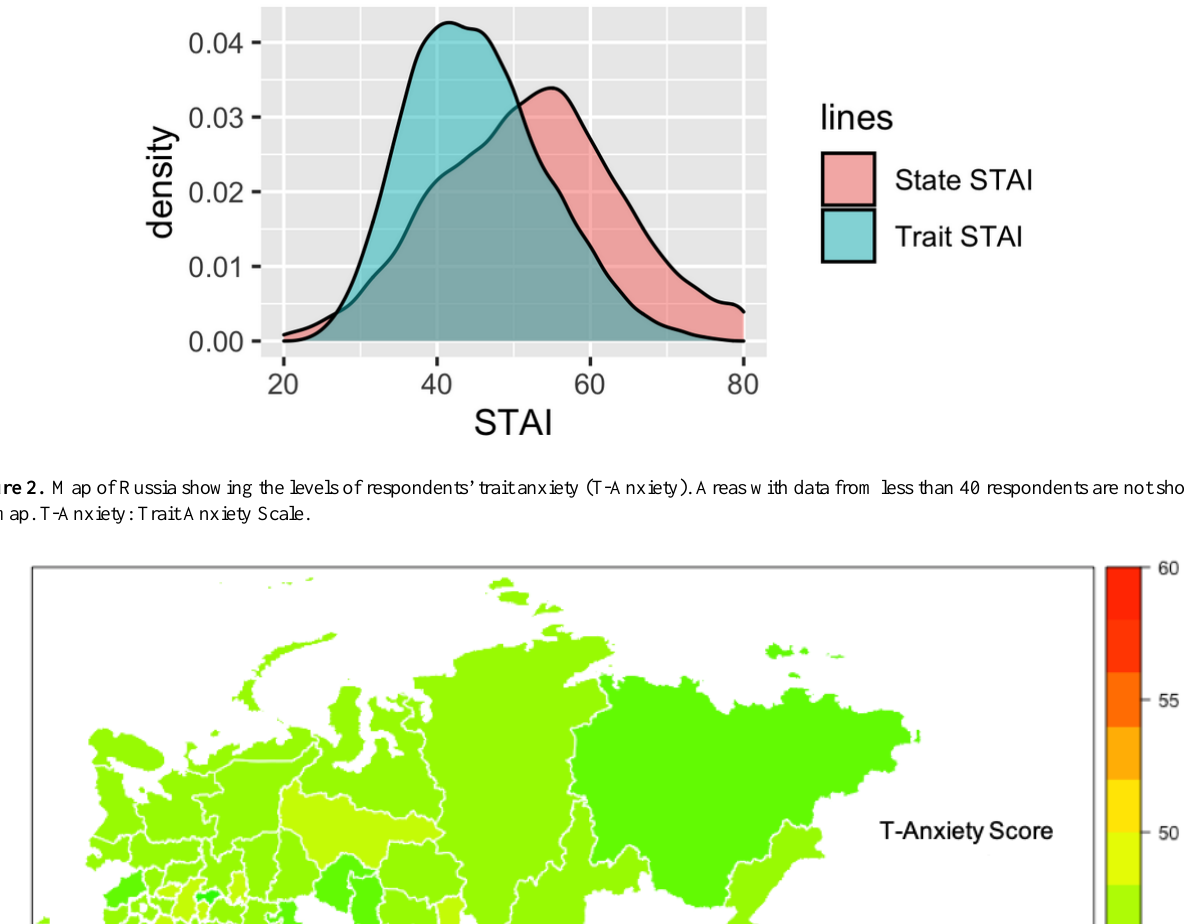
Figure 1. Density plot showing the difference between the state and trait anxiety based on the responses of all participants (N=21,364). STAI: State-Trait Anxiety Inventory.